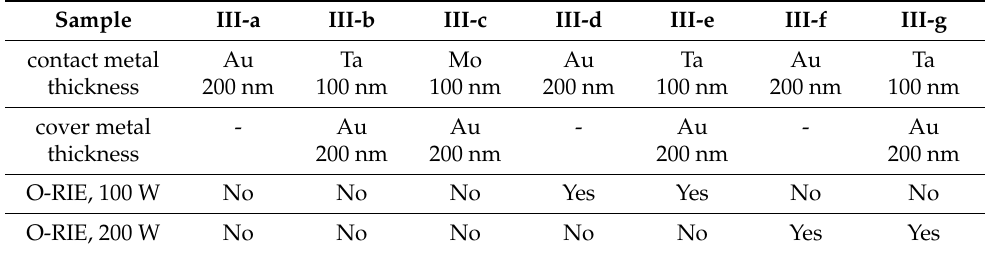
Table 1. Sample group based on different metallization and O-RIE parameters.